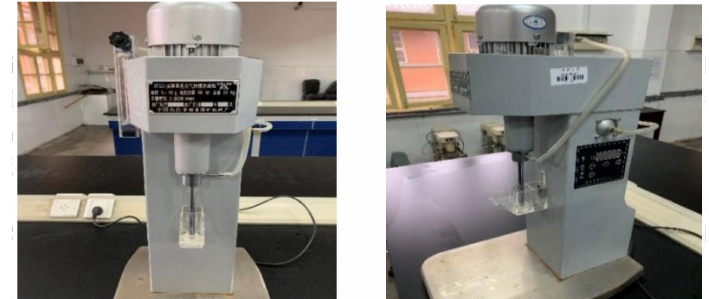
Figure 3. The image of microflotation machine (XFGC II , Jilin Exploration Machinery Plant, Changchun, China).